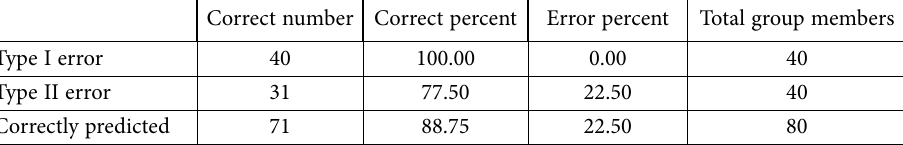
Table 7. Model prediction for three years prior to bankruptcy or insolvency (source: authors’ processing) Correct number Correct